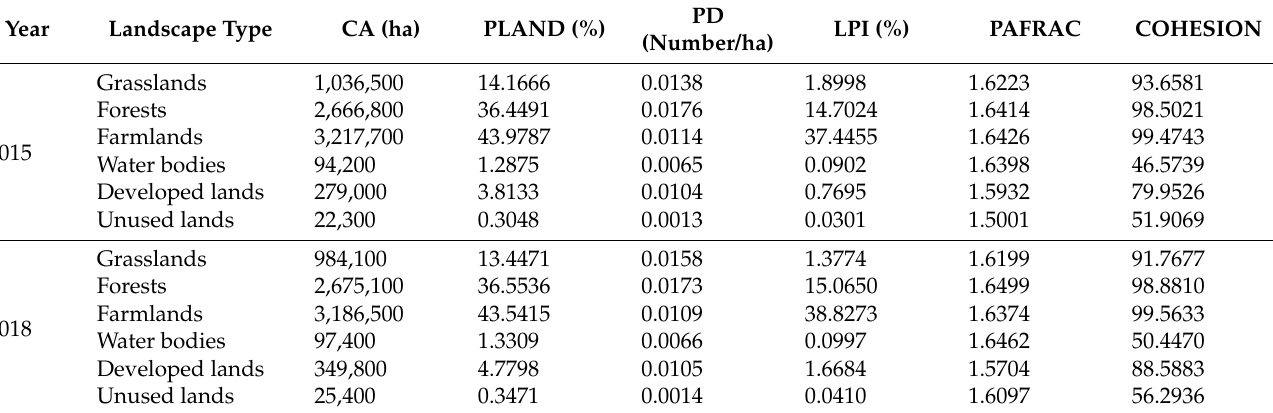
Table 2. Structural characteristics of different landscape types in the Chengdu Plain urban agglomeration.